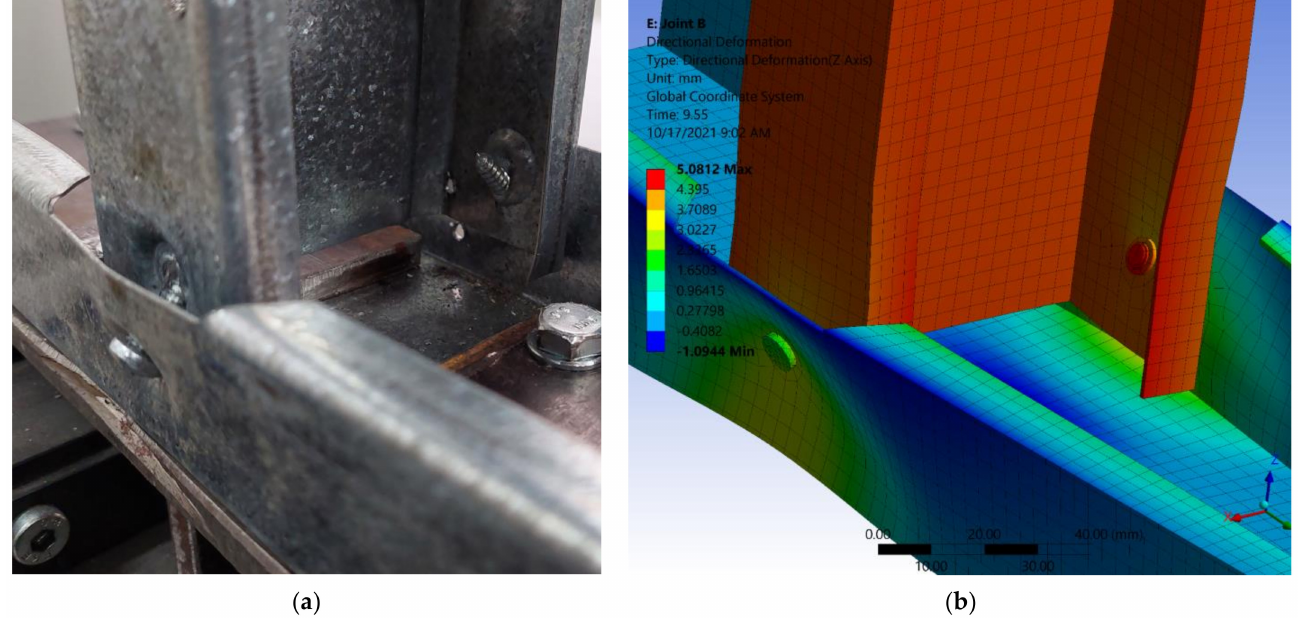
Figure 31. Displacements of joint B—deformed shape: ( a ) experimental; ( b ) numerical model.